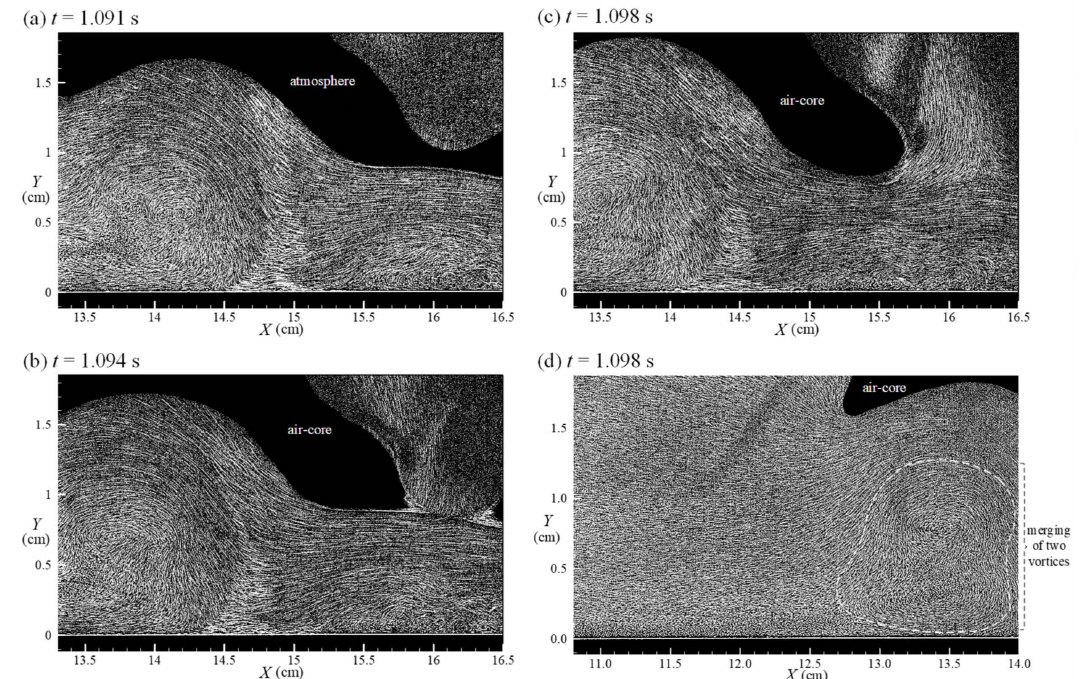
Figure 17. Visualized images of interaction process between projecting jet and retreated flow at ( a ) t = 1.085 s before jet impinging; ( b ) t = 1.094 s for jet right impinging on retreated flow; ( c ) t = 1.098 s for jet bifurcating into two substreams; and ( d ) t = 1.098 s for merging of vortices (Case